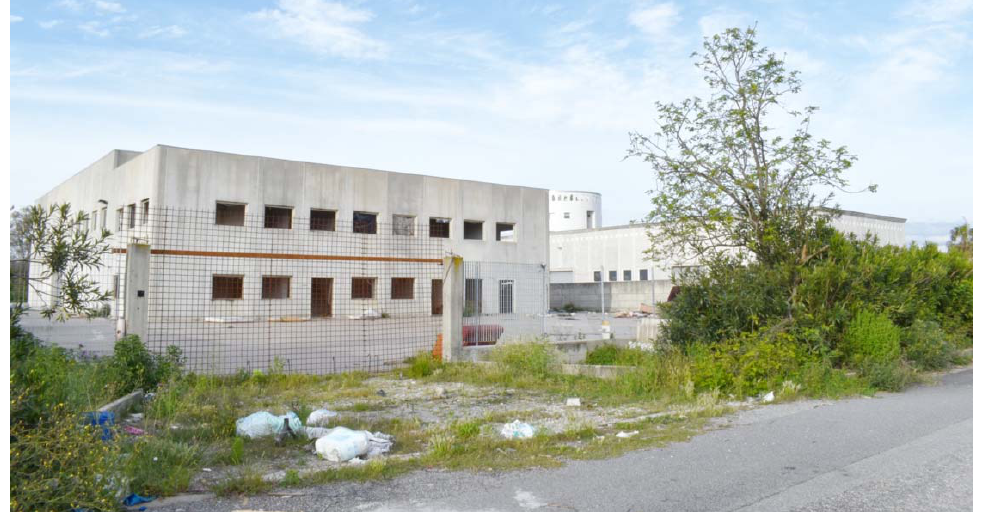
Figure 1. The disused industrial area abutting the San Ferdinando settlement.